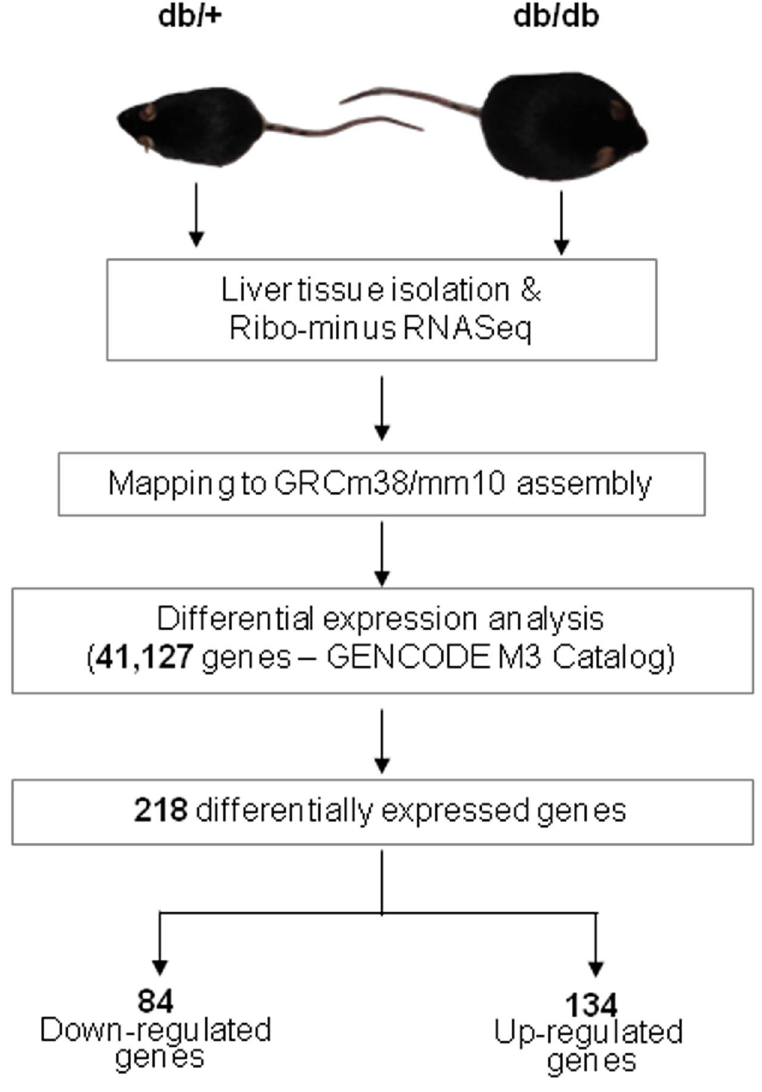
Figure 1. Schema of the experimental workflow. Summary and overview of experimental and computational workflow adopted in this study to identify genes differentially expressed between normal (db/ + ) and diabetic (db/db) mice